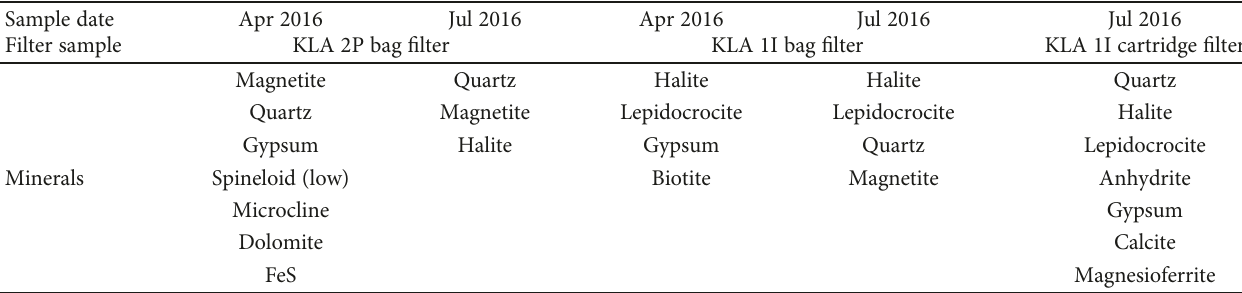
Table 8: Minerals identi fi ed (by X-ray di ff raction) in fi lter residue from bag and cartridge fi lters installed on the KGDP brine